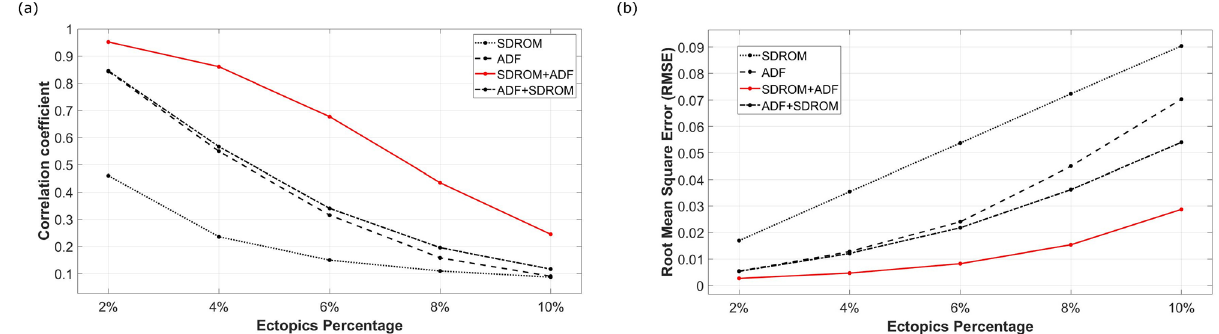
Figure 4. Comparison of performance indicators for ectopic filters ( a ) , Mean correlation coefficient for SDROM, ADF, SDROM-ADF, and ADF-SDROM denoising algorithm at different levels of ectopic noise, ( b ), Mean RMSE for SDROM, ADF, SDROM-ADF, and ADF-SDROM denoising algorithm at different levels of ectopic noise.